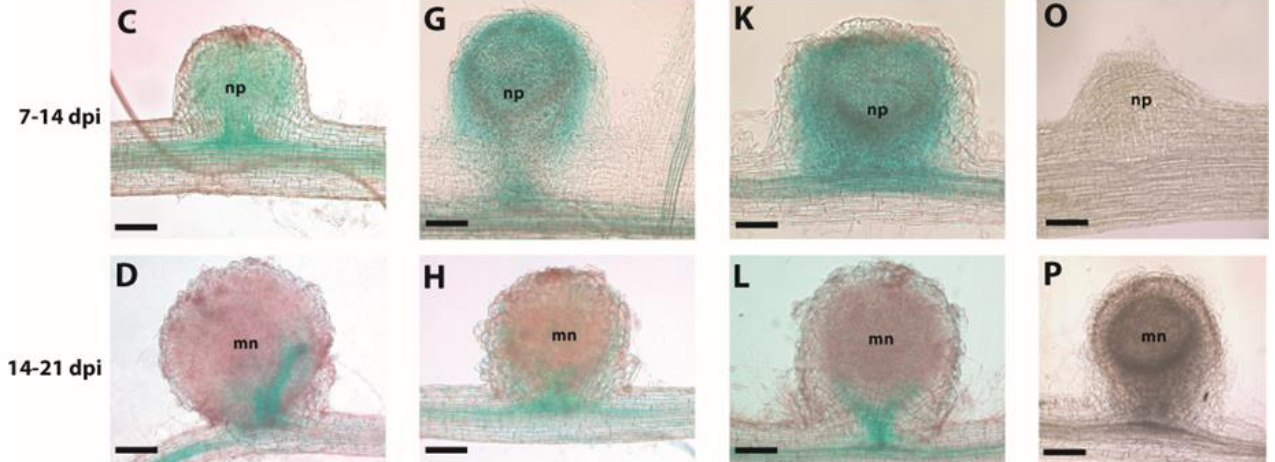
Figure 1. PvFER1, PvRALF1 , and PvRALF6 gene promoters are active during nodule organogenesis. Bright-field images of common bean transgenic roots expressing proFER1 ::GUS ( A – D ), proRALF1 ::GUS ( E – H ), or proRALF6 ::GUS ( I – L ). An empty vector (EV) was used as a control to rule out false positives ( M – P ). Promoter activity was visualized by GUS staining at different times after rhizobia inoculations (3–5, 5–7, 7–14, and 14–21 dpi). r, rhizodermis; c, cortex; np, nodule primordium; mn, mature nodule. The scale bar represents 500 μm.